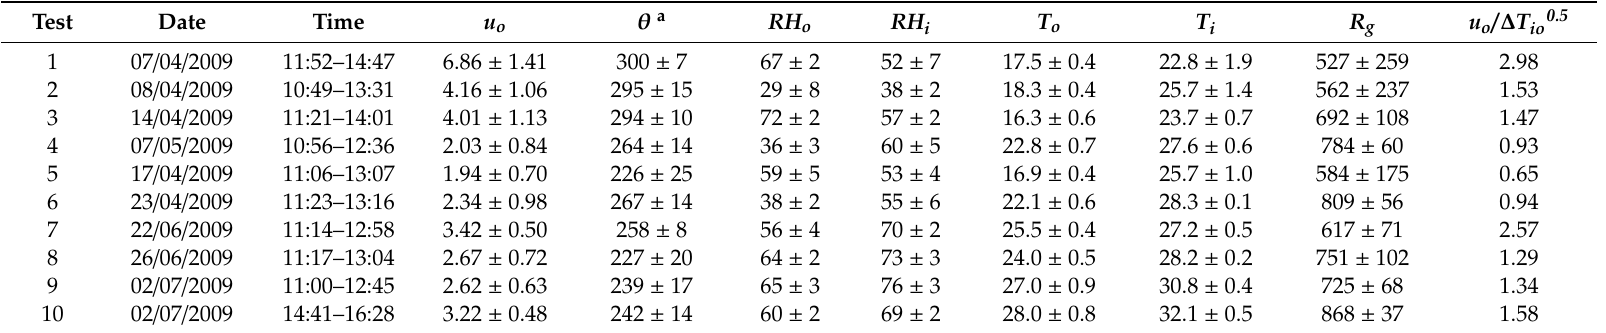
Table 1. Outside climatic conditions for the measurement tests. Average wind speed u o [m s − 1 ], wind direction θ [ ◦ ], outside and inside temperature T o and T i [ ◦ C], outside and inside humidity RH o and RH i [%], outside radiation R g [W m − 2 ] and ratio determining the relative importance of the wind and thermal buoyancy forces u o / ∆ T io0.5